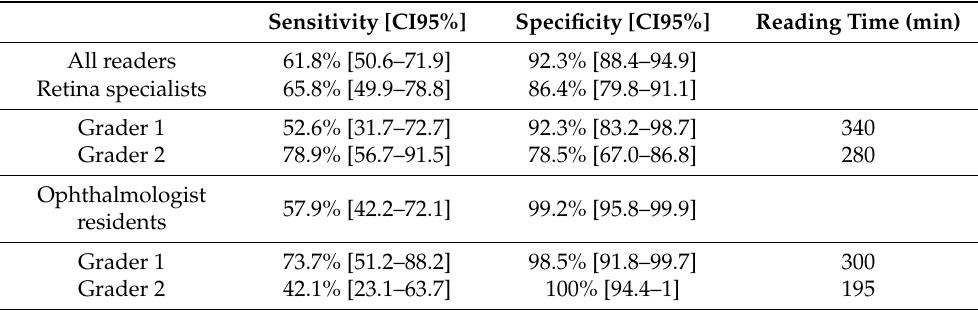
Table 4. Sensitivity and specificity of UWF-FP for detection of neovascular lesions ( n = 19 eyes in stage 3) and reading time of 84 images per